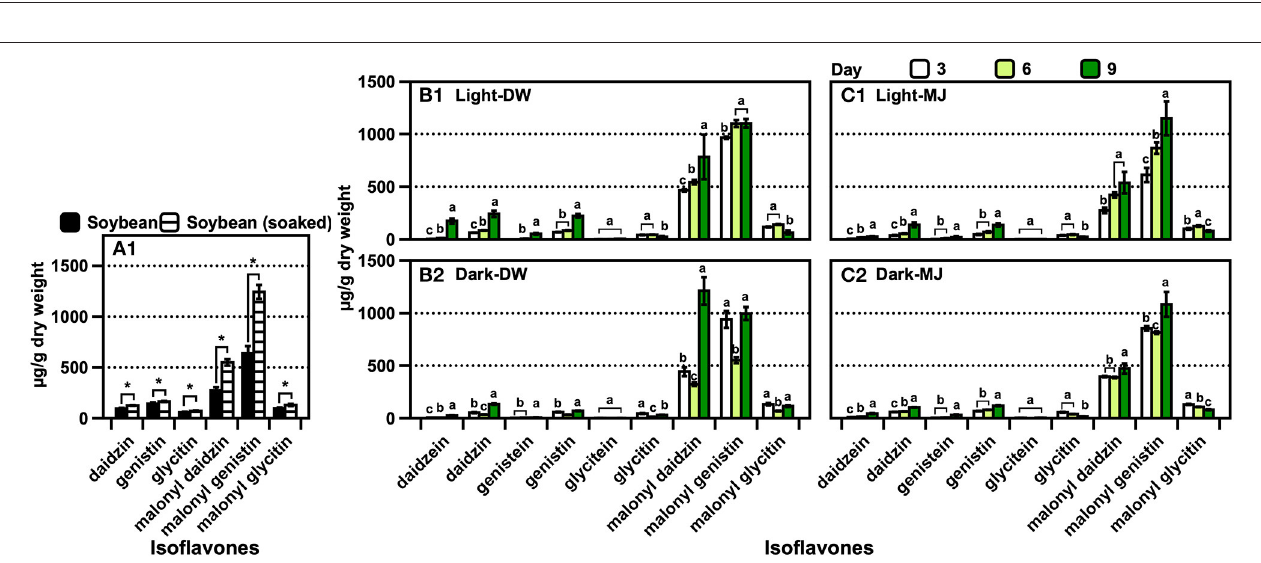
FIGURE 5 | Contents of isoflavones and kaempferol glycosides of (A) soybean AR and (B) soybean plants cultivated in AS. The data are expressed as the mean ± standard error of the mean. Asterisk “*” on the bar indicates the significant differences of the comparisons for each pair by Student’s t -test at an α = 0.05 level.